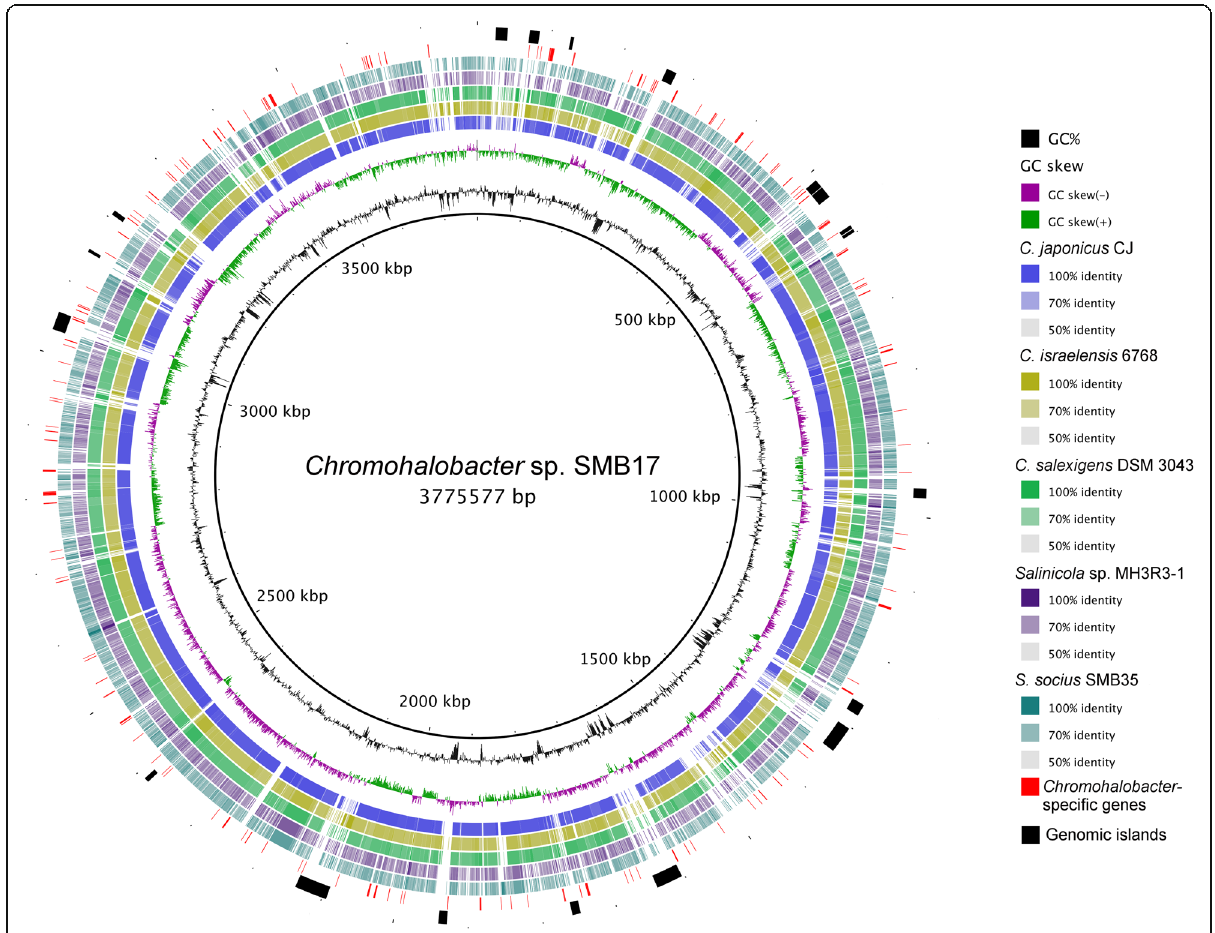
Fig. 4 Circular representation of the Chromohalobacter sp. SMB17 genome and its comparison to genomes of the Salinicola-Chromohalobacter group. Rings from inside to outside: (1) GC content, (2) GC skew, (3) BLASTn comparison with C. japonicus CJ, (4) BLASTn comparison with C. israelensis 6768, (5) BLASTn comparison with C. salexigens DSM 3043 T , (6) BLASTn comparison with Salinicola sp. MH3R3 – 1, (7) BLASTn comparison with S. socius SMB35 T , (8) Genome segments present in all Chromohalobacter genomes, but absent from genomes of Salinicola spp., (9) Genomic islands predicted in the Chromohalobacter sp. SMB17 genome. The genome comparisons were visualized using the BRIG software [26]. The inner scales designate the coordinates in kilobase